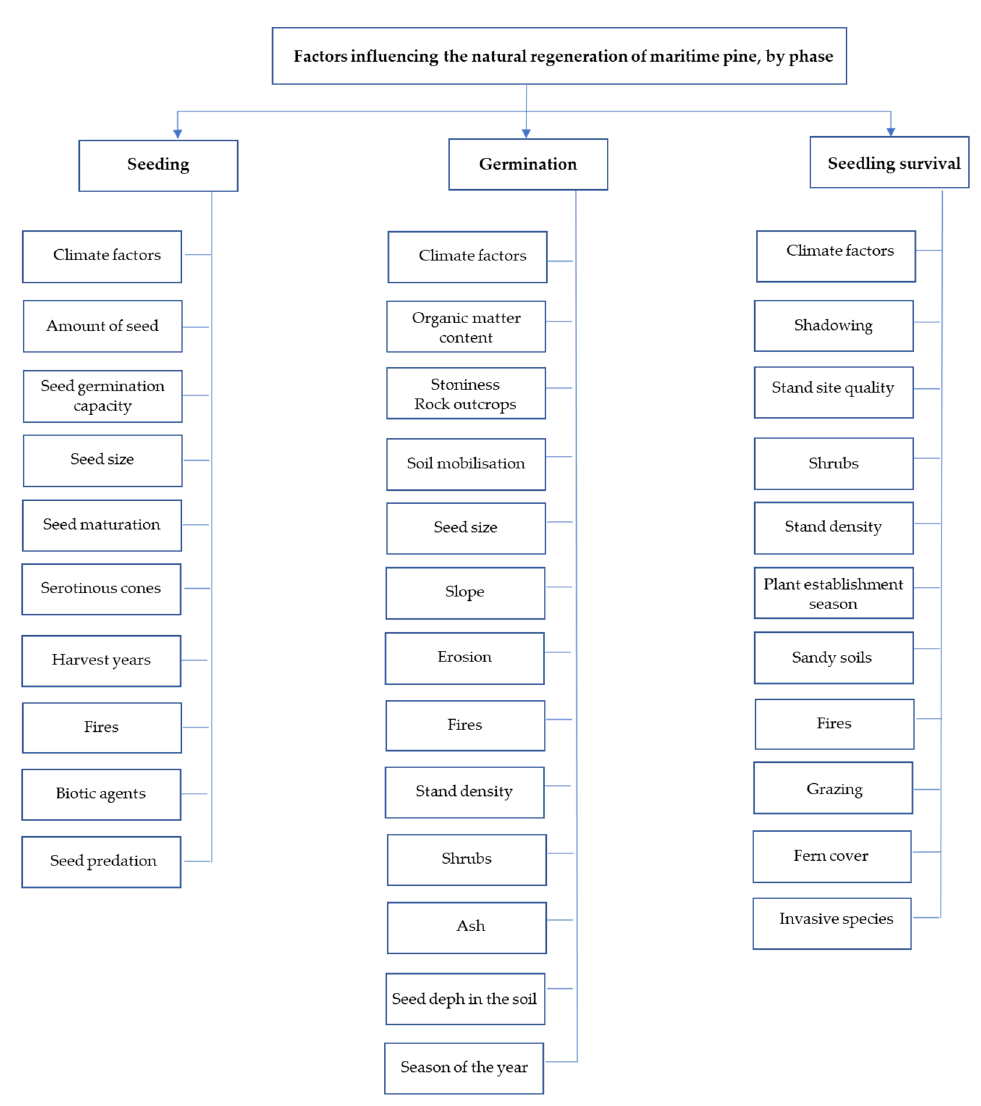
Figure 1. Factors that influence the natural regeneration of maritime pine.